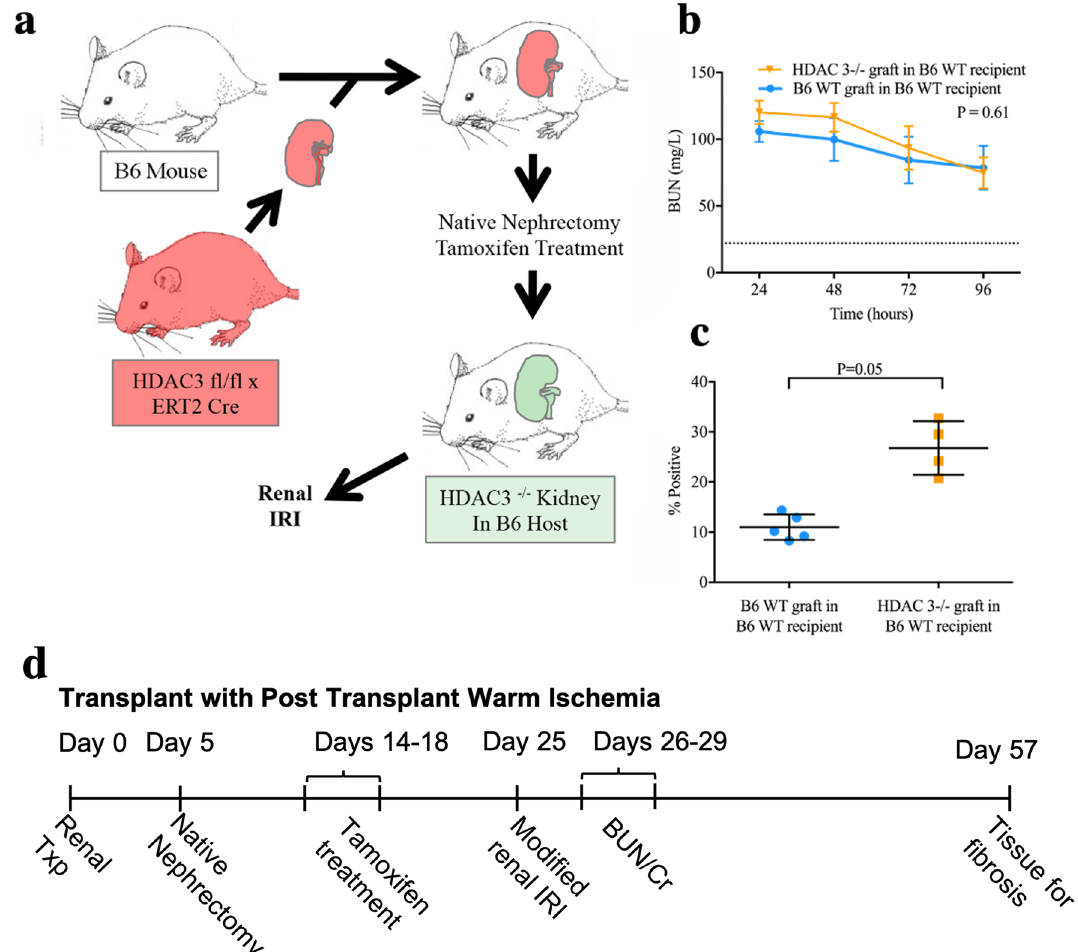
Figure 2. ( a ) Strategy for selective renal HDAC3 deletion prior to renal IRI: kidneys from B6 mice bearing floxed HDAC3 and CreER T2 transgenes were engrafted into WT B6 mice, followed by native nephrectomy and tamoxifen induction, and subsequently renal IRI. ( b ) BUN following 25 min of warm IRI in HDAC3-deleted renal isografts and WT renal isografts; data are expressed as mean ± SEM, and significance was determined by 2-way ANOVA (n = 5 mice/group). ( c ) Computerized scoring of renal fibrosis with Sirius Red staining at 28 days post-IRI in HDAC3- > WT (n = 4) and WT- > WT (n = 5) isografts; data were expressed as mean ± SD, and significance was determined by unpaired t-test. ( d ) Experimental timeline for renal transplant with